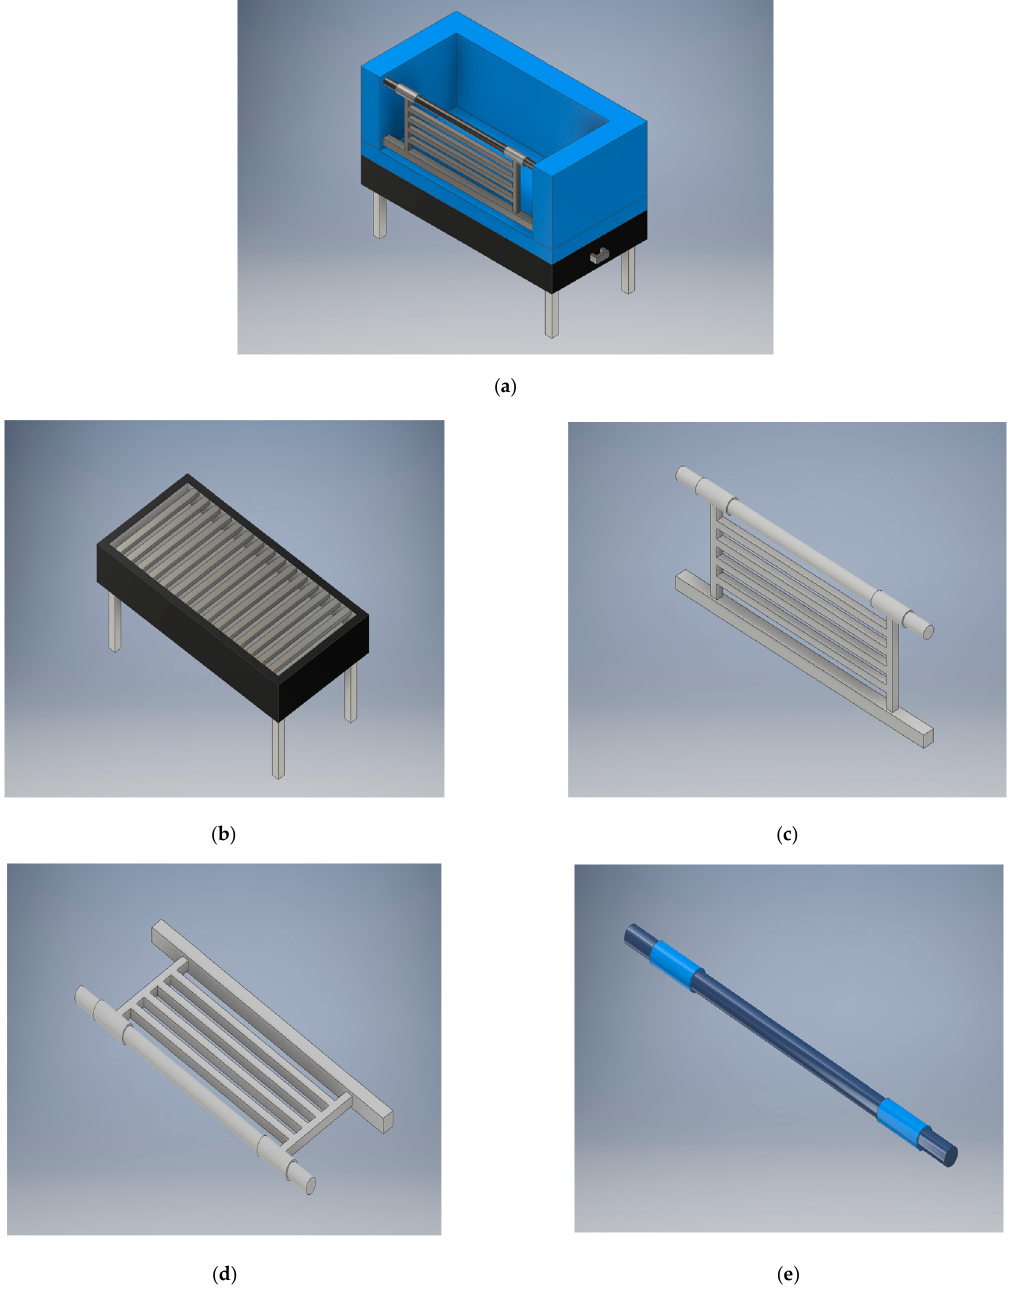
Figure 3. Repurposed parts of concept 2. ( a ) Crib design. ( b ) Grill design. ( c ) Safety door design. ( d ) Dying rack design. ( e ) Pull-up bar design.